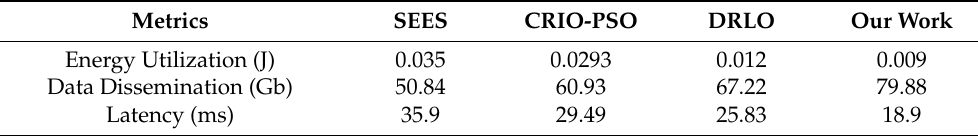
Table 1. Comparative analysis for varying IoT edge nodes.